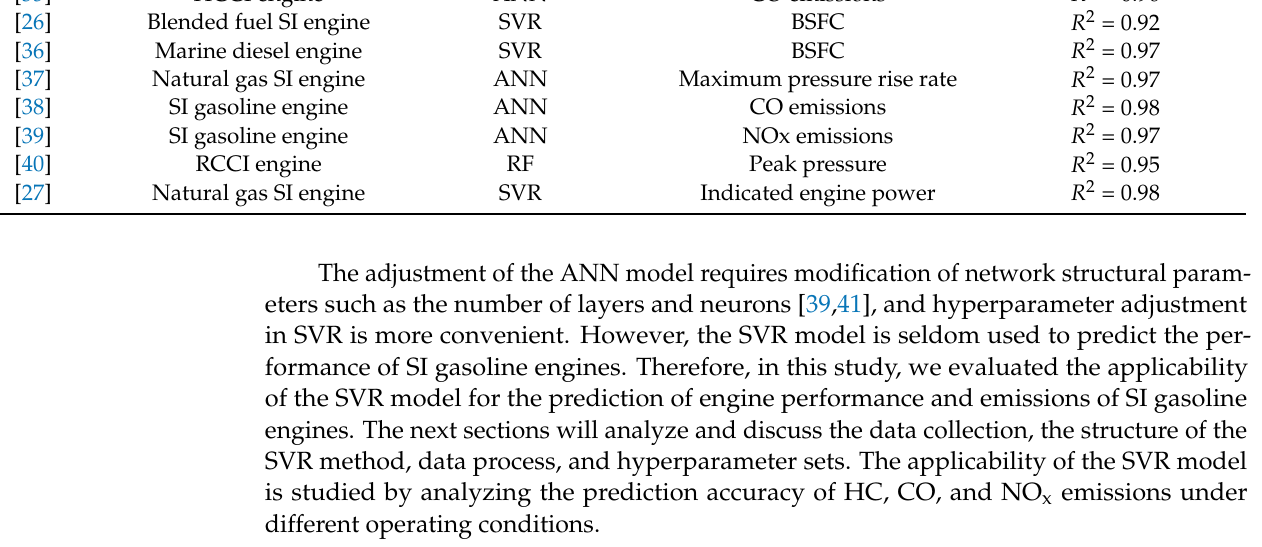
Table 1. The predicted performance of some available studies.